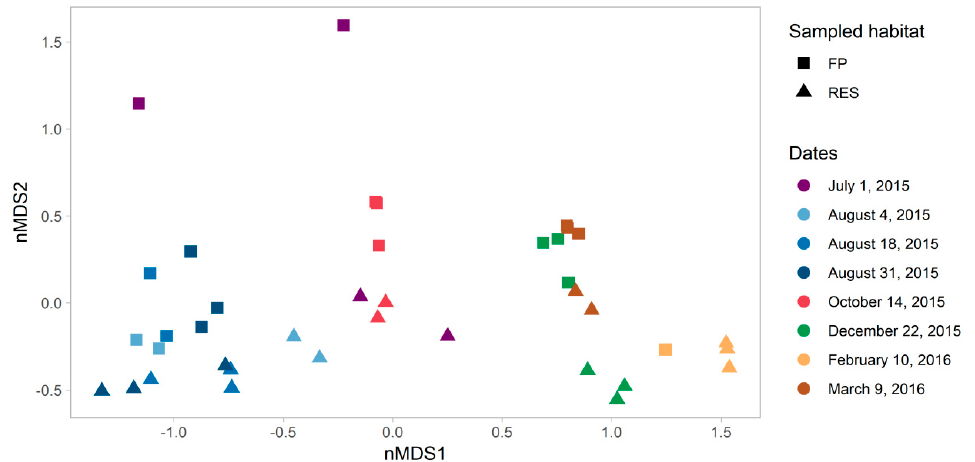
Figure 2. Non-metric multidimensional scaling (NMDS) biplot of a Bray–Curtis dissimilarity matrix of 16S rRNA gene amplicon sequencing data, showing the microbial community structure of 8 sampling points from FP-03 (FP- squares) and the Res (Res- triangles) at the Dor aquaculture research station. Stress = 0.06.